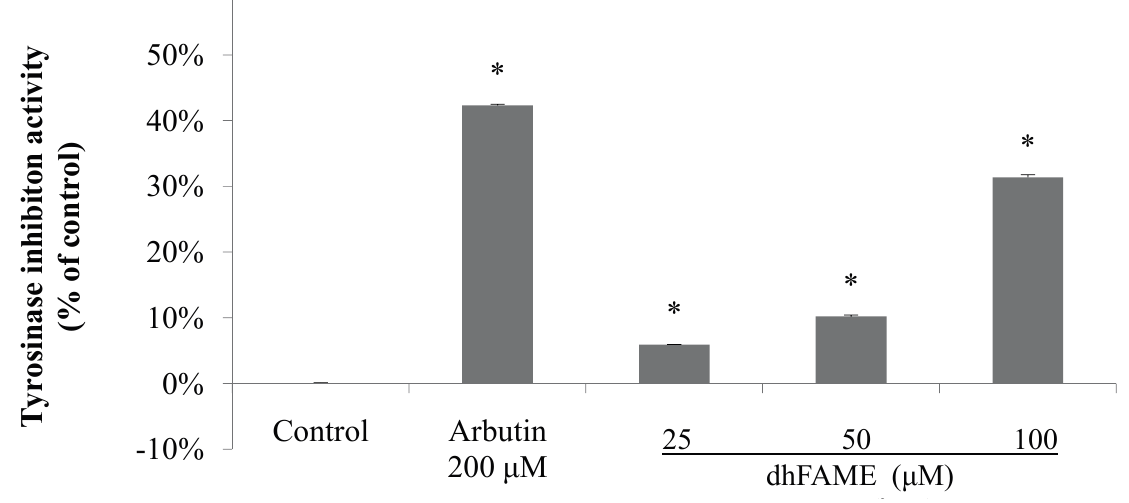
Figure 2. Effect of dhFAME against mushroom tyrosinase. Tyrosinase was preincubated with test substances at 25 °C for 5 min prior to incubation with L -tyrosine for 30 min, and absorbance was read at 490 nm. Each determination was made in triplicate, and the data shown represent the mean ± standard deviation. Statistical significance (* p < 0.05) was determined using Student’s t-